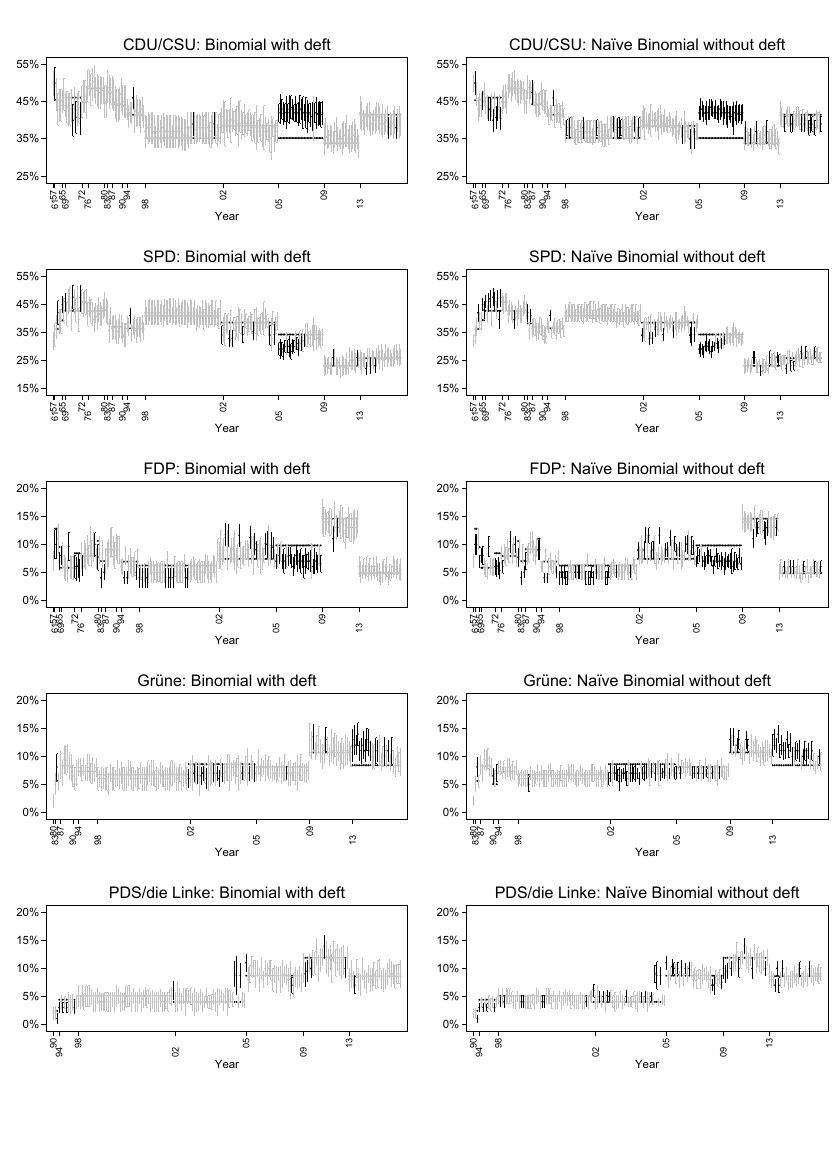
Figure 6 : Performance of naïve binomial 95%-CIs without deft (right), in com- parison to binomial 95%-CIs with deft (left) over time. Pre-election polls are arranged chronologically. Gray CIs contain the election result, black CIs do not contain the election result. Point estimates are shown as